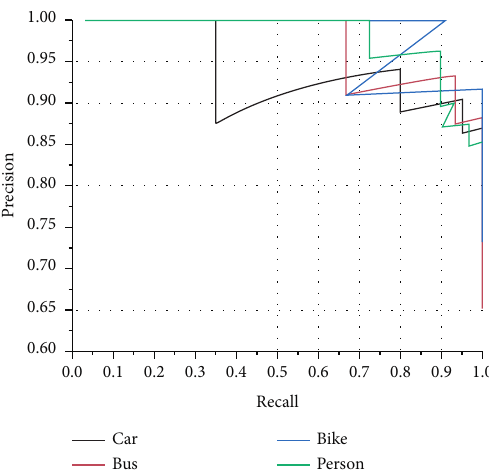
Figure 8: Normal video classification P-R curve.